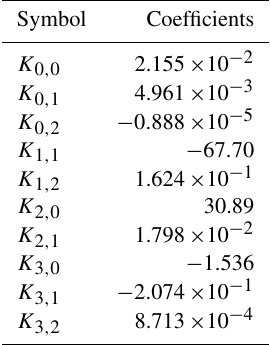
Table 3. Coefficients for TUD correction (Eq.